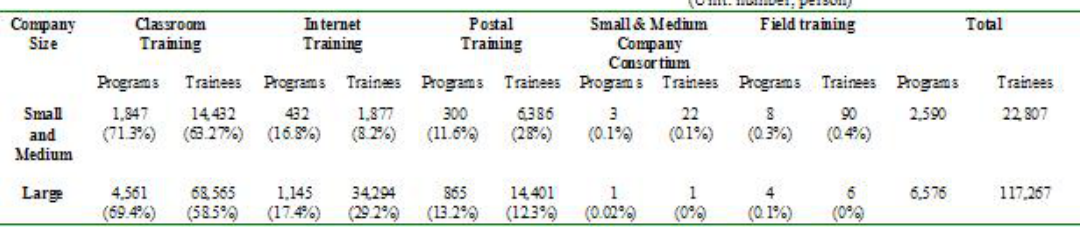
Table 3. The Proportion of Training Types for Assembly Line Workers by Company